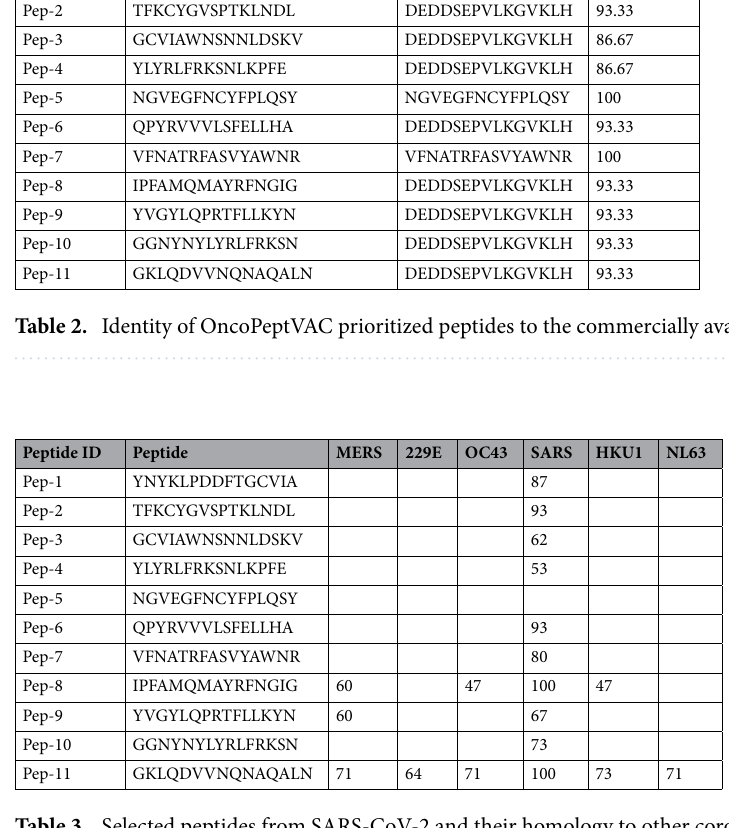
Table 3. Selected peptides from SARS-CoV-2 and their homology to other coronaviruses. Sequence identity of the shortlisted 15-mer peptides against homologous peptides in other coronaviruses as identified based on an E-value cut-off of 0.01 and a minimum cut-off length of 11 amino acid residues.